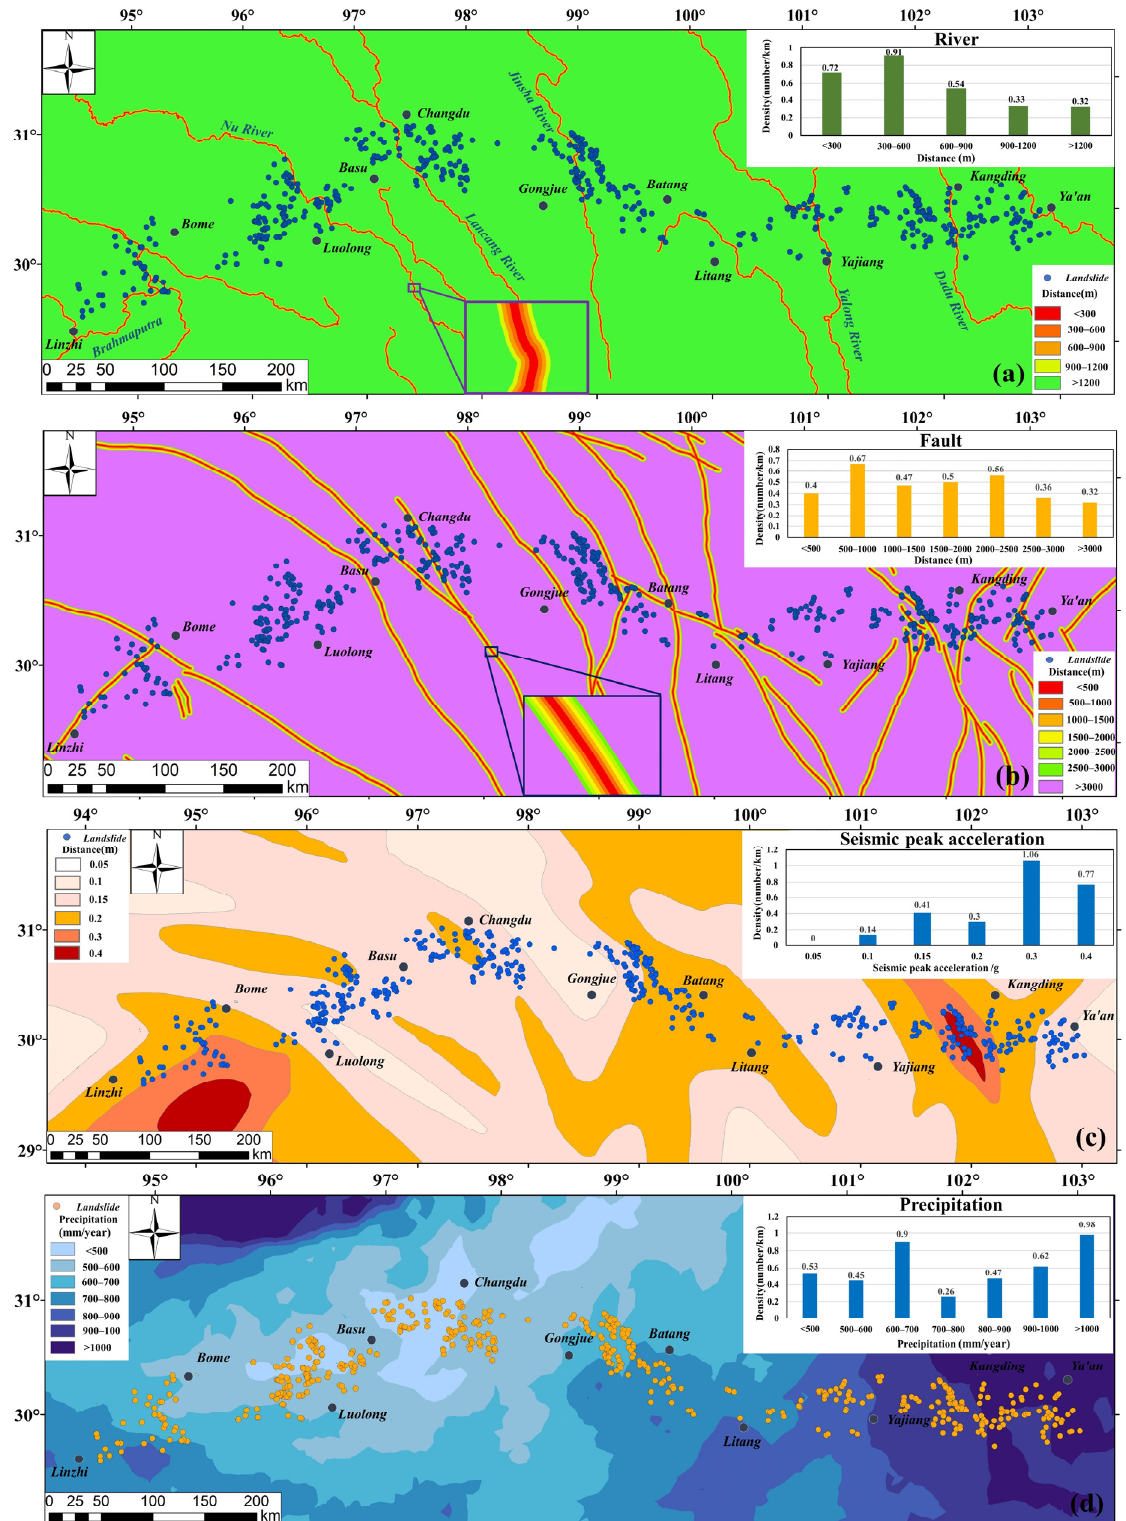
Figure 12. Relationships between horizontal geological factors and landslides. Relationships between ( a ) river and spatial landslide distribution; ( b ) fault zone and spatial landslide distribution; ( c ) seismic peak acceleration and spatial landslide distribution; and ( d ) precipitation and spatial landslide distribution. The statistical charts of each factor are displayed in the upper-right corner in each map.